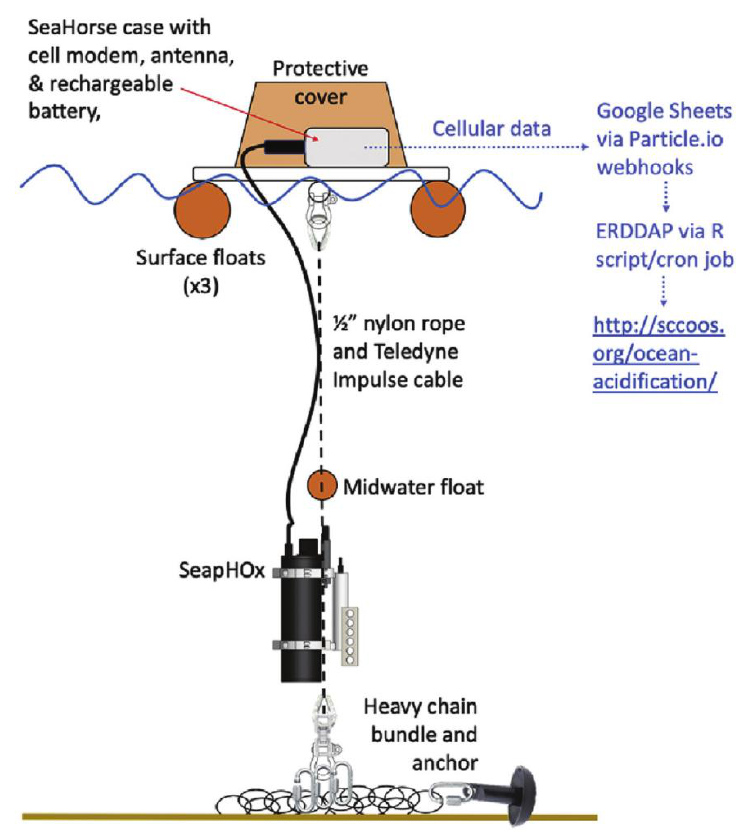
Figure 10. Water quality monitoring system